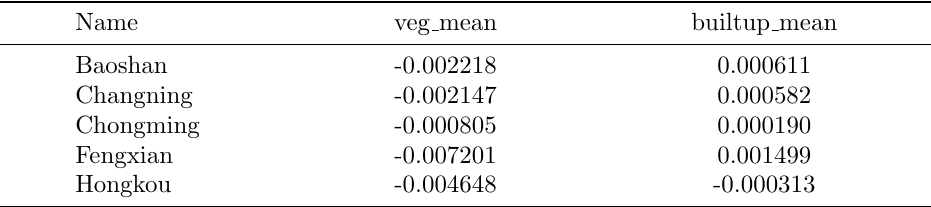
Table 9: Partial vegetation and built-up features identified in